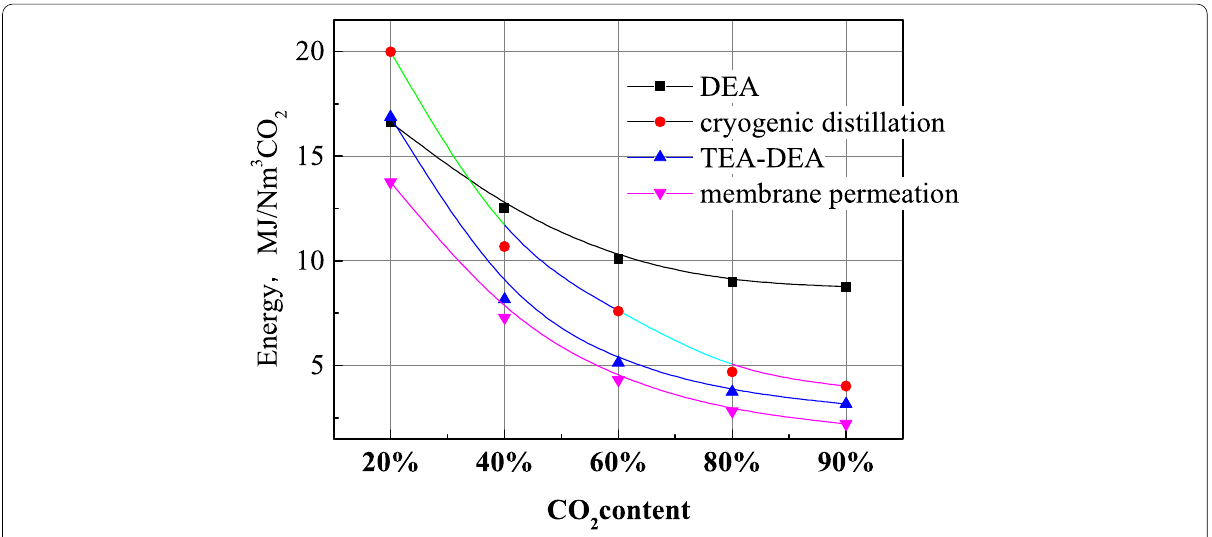
Fig. 3 Equivalent heat requirements for CO 2 extraction